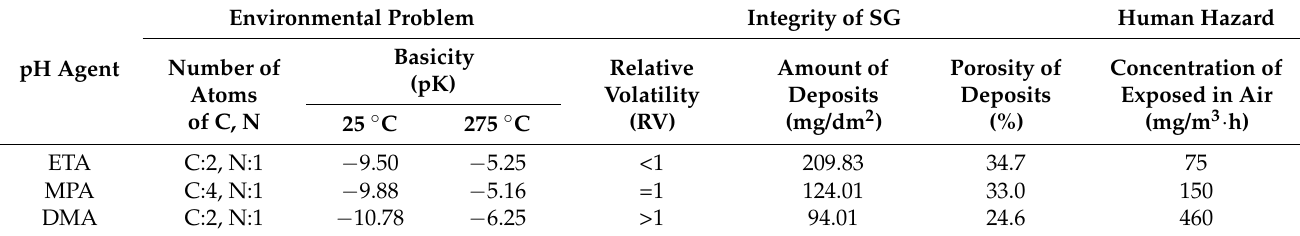
Table 4. Analysis of the possibility of substituting other advanced amines (MPA or DMA) in place of ETA, an amine widely used in the secondary water of